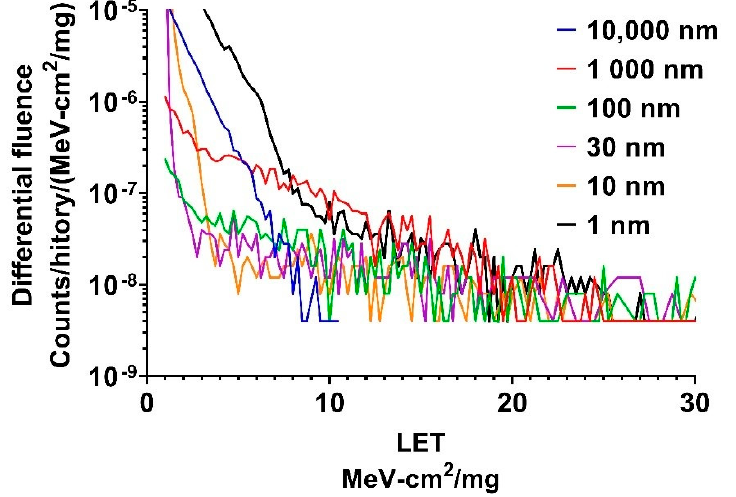
Figure 2. Lineal energy spectra of different sensitive volumes in silicon irradiated by a 200 MeV proton beam.